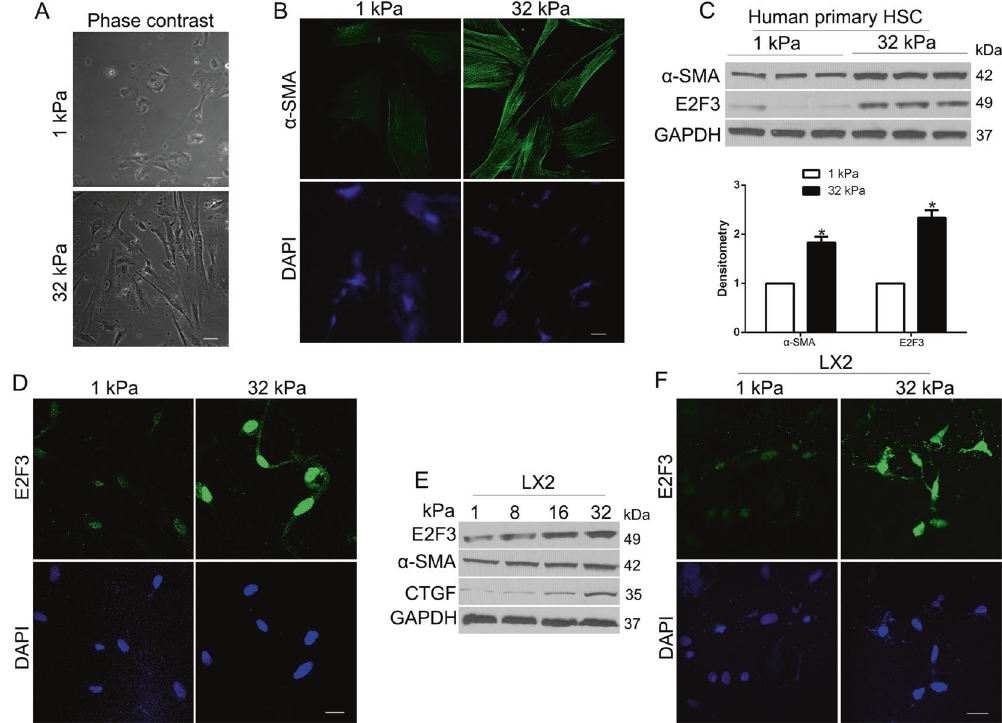
Fig. 1 Substrate stiffness promotes E2F3 expression and MF activation of HSCs. A HSCs were plated on a 1 or 32 kPa hydrogel and subjected to phase-contrast microscopy. B IF for α -SMA detected HSC activation-induced by increasing stiffness. C HSCs were plated on a 1 or 32 kPa hydrogel and subjected to WB with quantitative data shown. 32 kPa stiffness promoted HSC activation and E2F3 protein level. * P < 0.05 by t -test, n = 3 repeats. D IF assay was used to analyze stiffness-induced E2F3 nuclear expression. Cell nuclei were counterstained with DAPI. E LX2 cells plated on polyacrylamide hydrogels were collected for WB. F IF revealed nuclear expression of E2F3 in LX2 cells on 32 kPa. Cell nuclei were counterstained with DAPI.